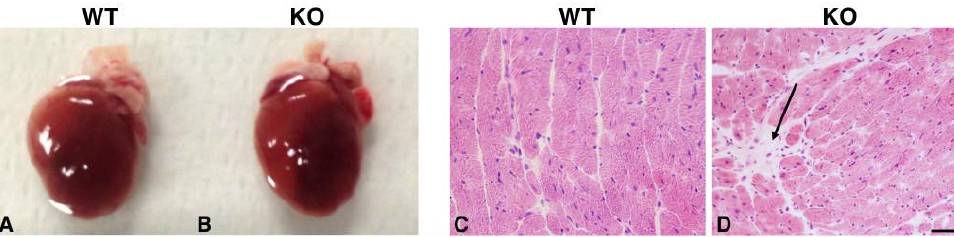
Figure 6. Analysis of the morphology of Hipk2 -KO heart. Representative images of heart morphology ( A , B ) and H&E staining ( C , D ) from 18-month-old WT and Hipk2 -KO mice are shown. The arrow in ( D ) indicates a fibrotic area. Original magnification, 40×. Scale bar = 20 μm.